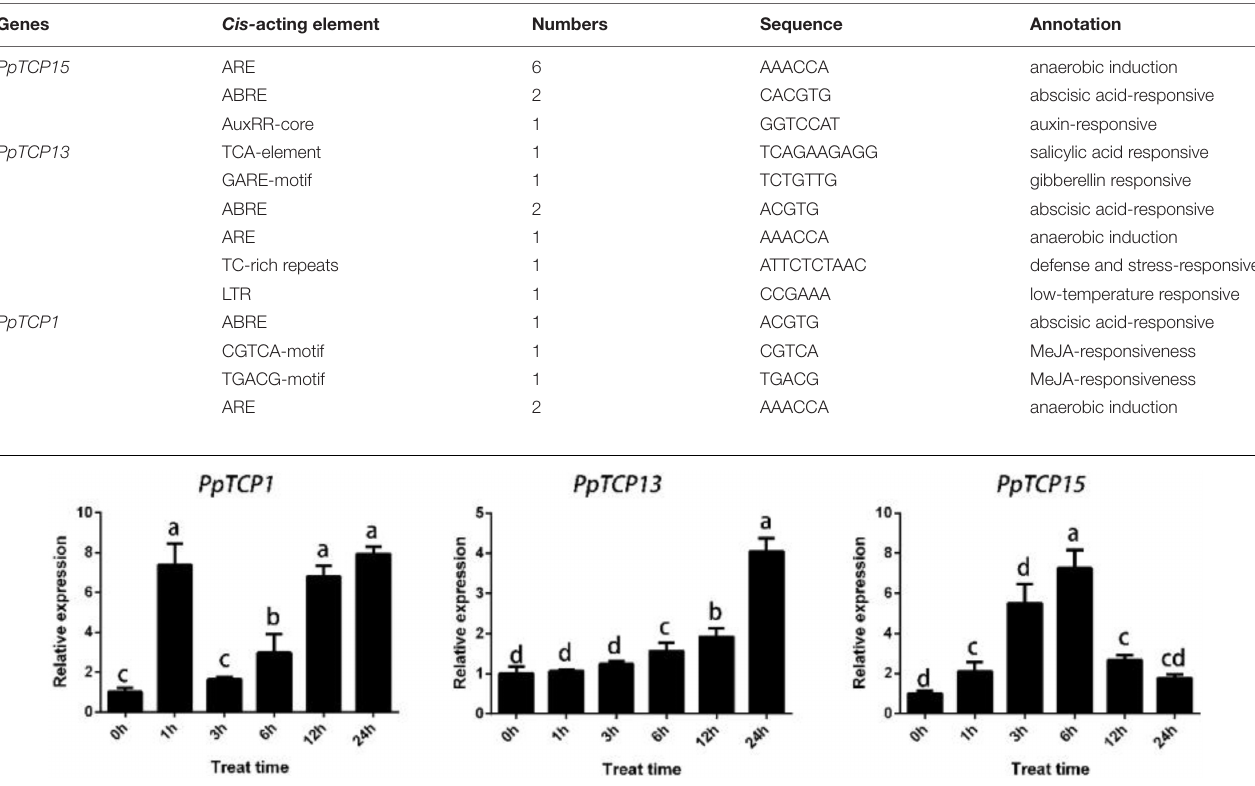
TABLE 1 | Analysis of cis- acting elements of PpTCP1, PpTCP13, and PpTCP15.